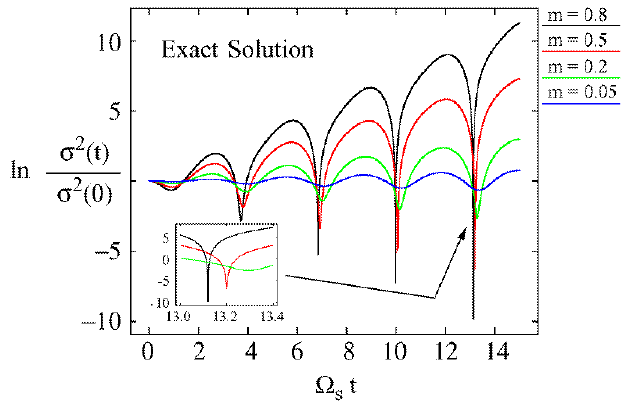
FIG. 2. (Color) Evolution of bunch length with time: numerical solution of Eq.